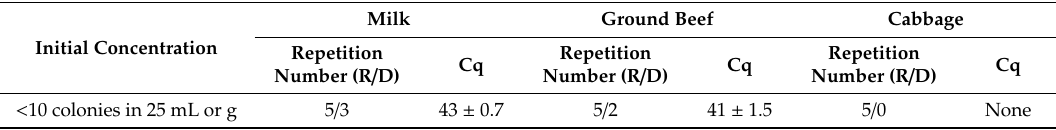
Figure 5. Detection of E. coli O157:H7 in 3 different food samples using a single colony. The automated IMS system was used with an incubation time of 120 min, and the recovered bacteria were analyzed by real-time PCR. ( a ) Fluorescence intensity of the signal depending on the amplification cycle for bacterial samples recovered from milk (red) and beef (green). ( b ) The average Cq values for milk and ground beef samples. Error bars represent standard deviation. Table 2. Cq value analysis with standard deviations and number of repetitions / detections (R / D) of the real-time PCR assay using the samples recovered from E. coli O157:H7-contaminated food samples by the automated IMS process.